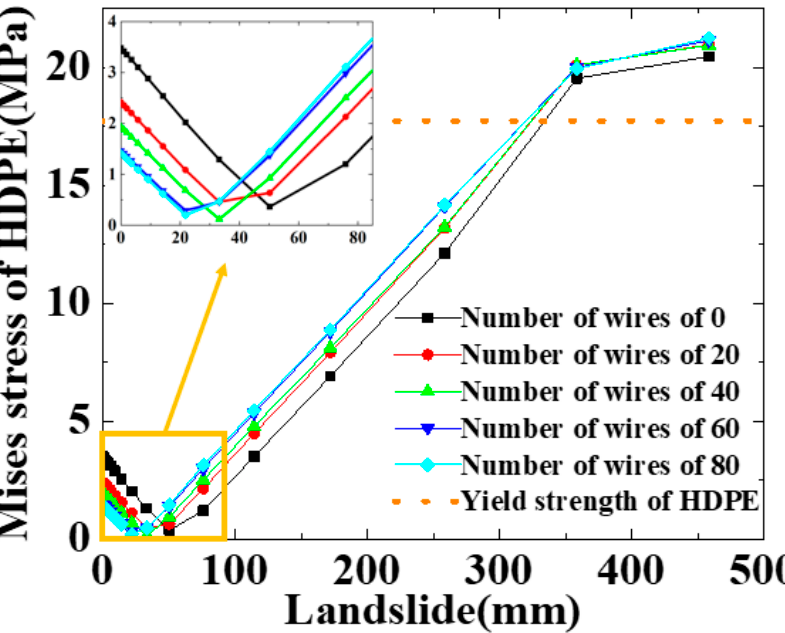
Figure 24. Influence of steel-wire number on variation in Mises stress at point B of SWW-RTP with the landslide.